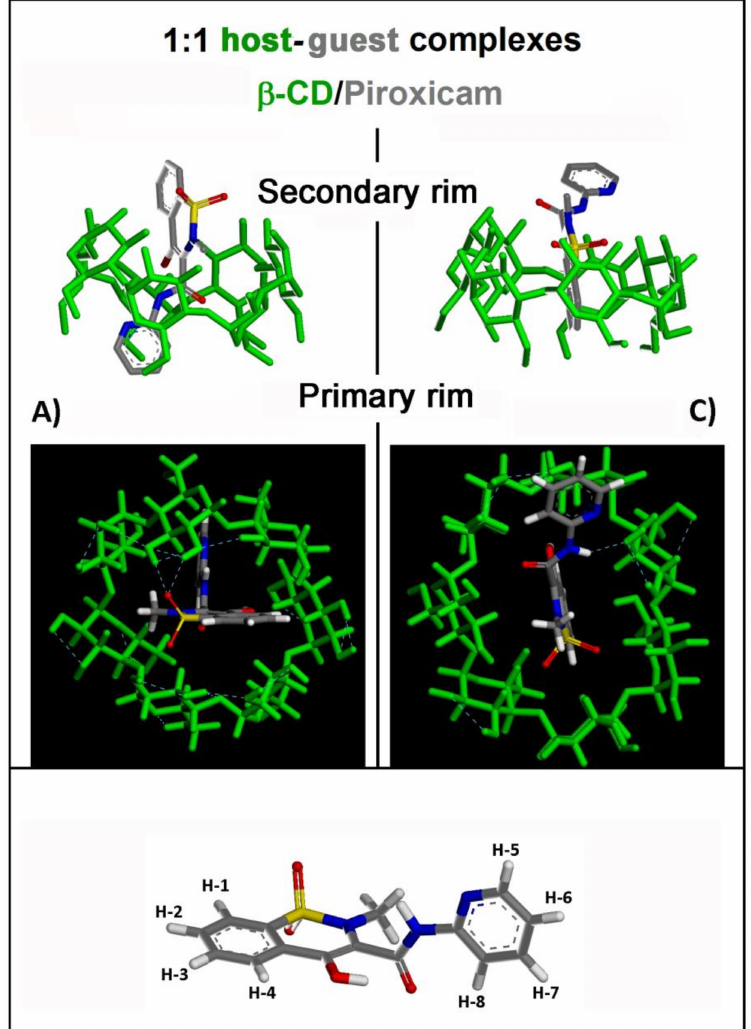
Figure 3. The side view and the top view with intermolecular H-bonds (light blue dotted line) of the 1:1 host–guest complexes formed by PX with β -CD ( A ) in the most stable and ( C ) in the less stable optimized geometries found after the MM, MD calculations. The β -CD is green, the PX molecule is colored by atoms (color codes: C atoms are grey, O atoms are red, N atoms are blue, S atoms are yellow, and in the side view, H atoms are omitted for clarity). Below, the conformation of the optimized isolated PX is reported with the diagnostic hydrogen